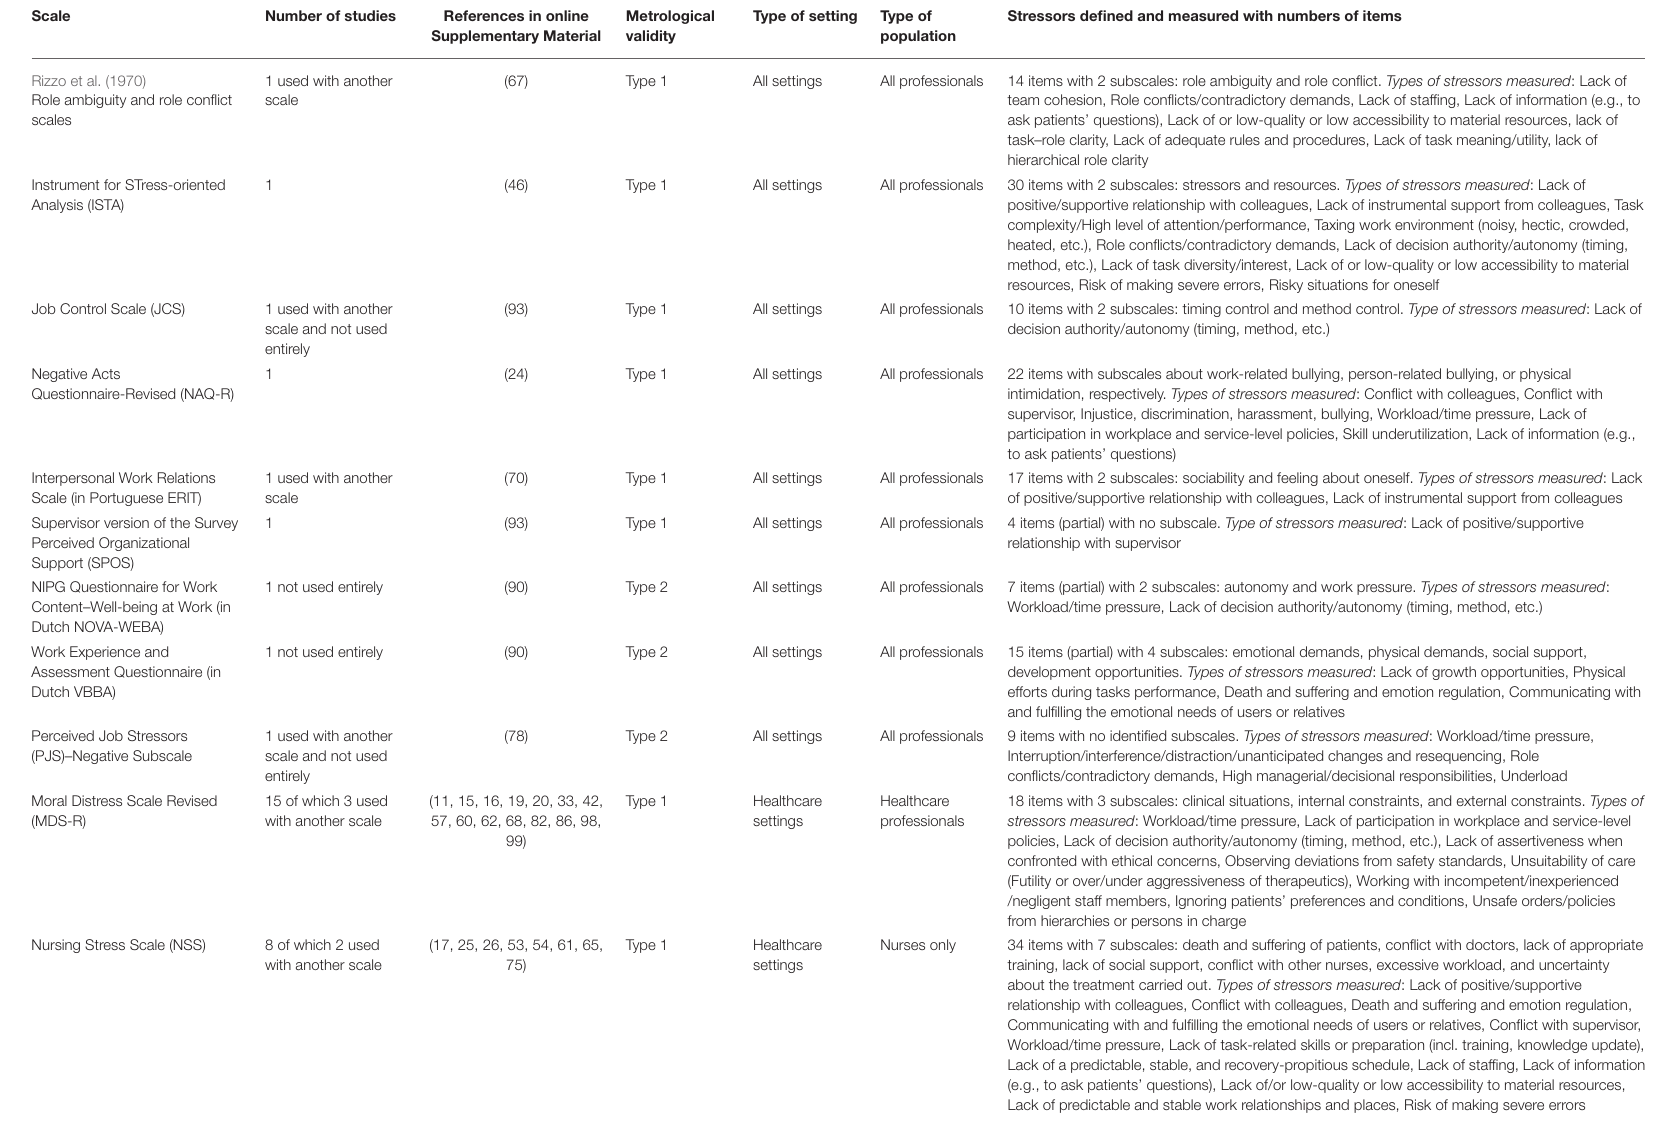
34 items with 7 subscales: death and suffering of patients, conflict with doctors, lack of appropriate training, lack of social support, conflict with other nurses, excessive workload, and